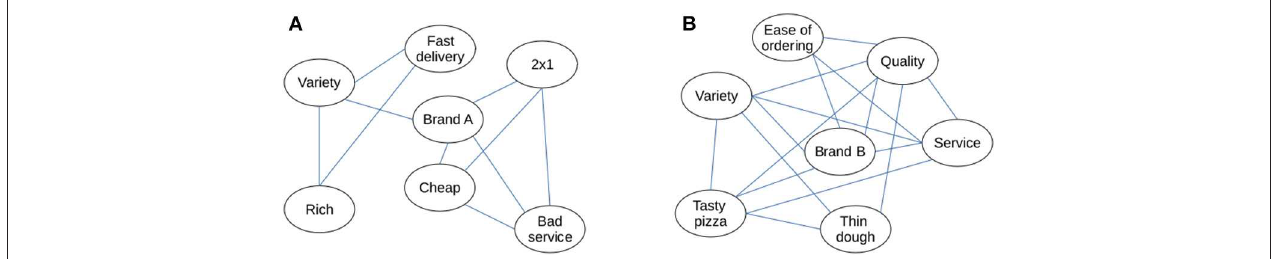
FIGURE 1 | Two consumer associative networks resulting from text-network analysis. (A) Shows a hypothesized network of customers’ comments for brand A. (B) Shows a hypothesized network of customers’ comments for brand